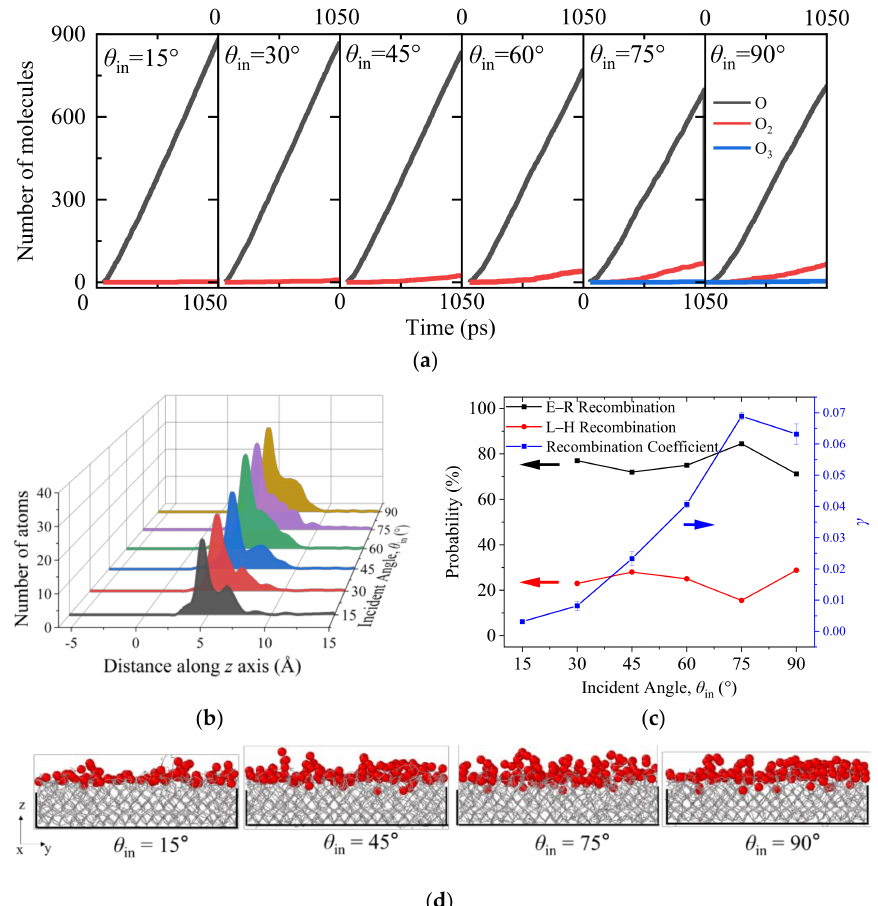
Figure 8. The effect of oxygen incident angle on the flow field, material response, and the silica surface catalysis characteristics by Models 1 and II-5–9. ( a ) The statistics of various species in the gaseous phase during the collisions, ( b ) the incident angle effect on the saturated z-density profiles of oxygen atoms on the silica surface, ( c ) the calculation of surface catalysis recombination coefficient and the detailed recombination mechanism analysis, and ( d ) snapshots for the final AO surface adsorption